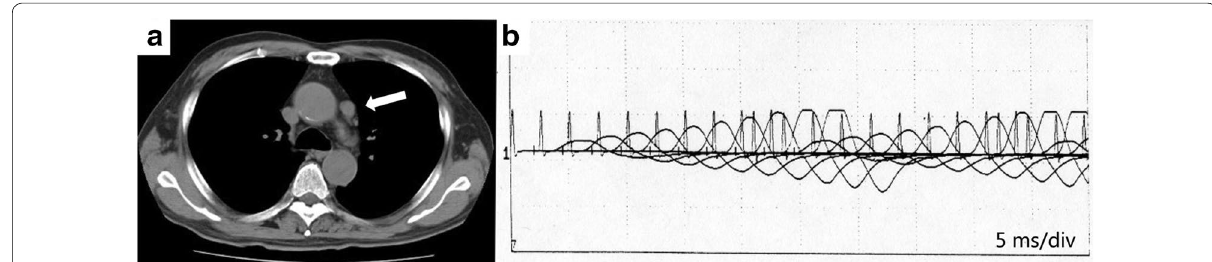
Fig. 1 Radiological findings and electromyography on a small cell lung carcinoma (SCLC) patient with Lambert–Eaton myasthenic syndrome (LEMS). a Chest computed tomography (CT) revealed mediastinal lymphadenopathy ( arrow ) on February 7, 2002. b Electromyography following stimulation at 50 Hz showed waxing on March 13, 2002